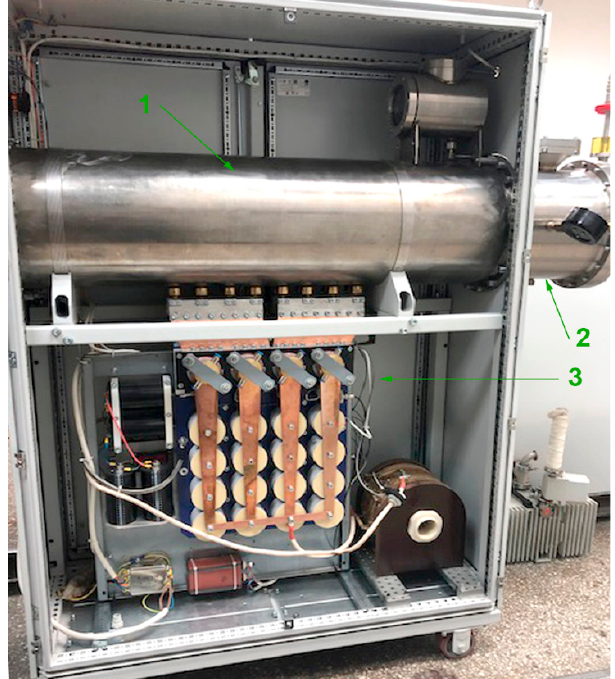
Figure 10. TWFL-based SINUS driver for low pulse repetition rates: 1–Tesla transformer with TWFL; 2–gas-gap switch chamber; 3–primary transformer circuit with thyristors, capacitors, and other elements.